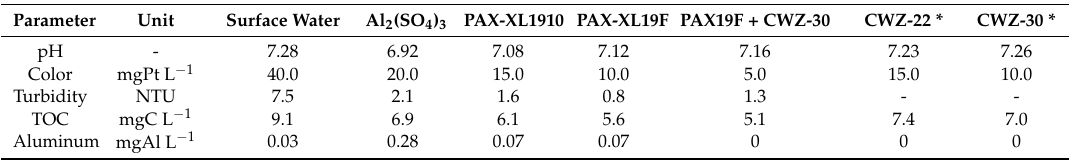
Table 3. Effect of coagulation and adsorption with various agents on selected physicochemical properties of water. Parameter Unit